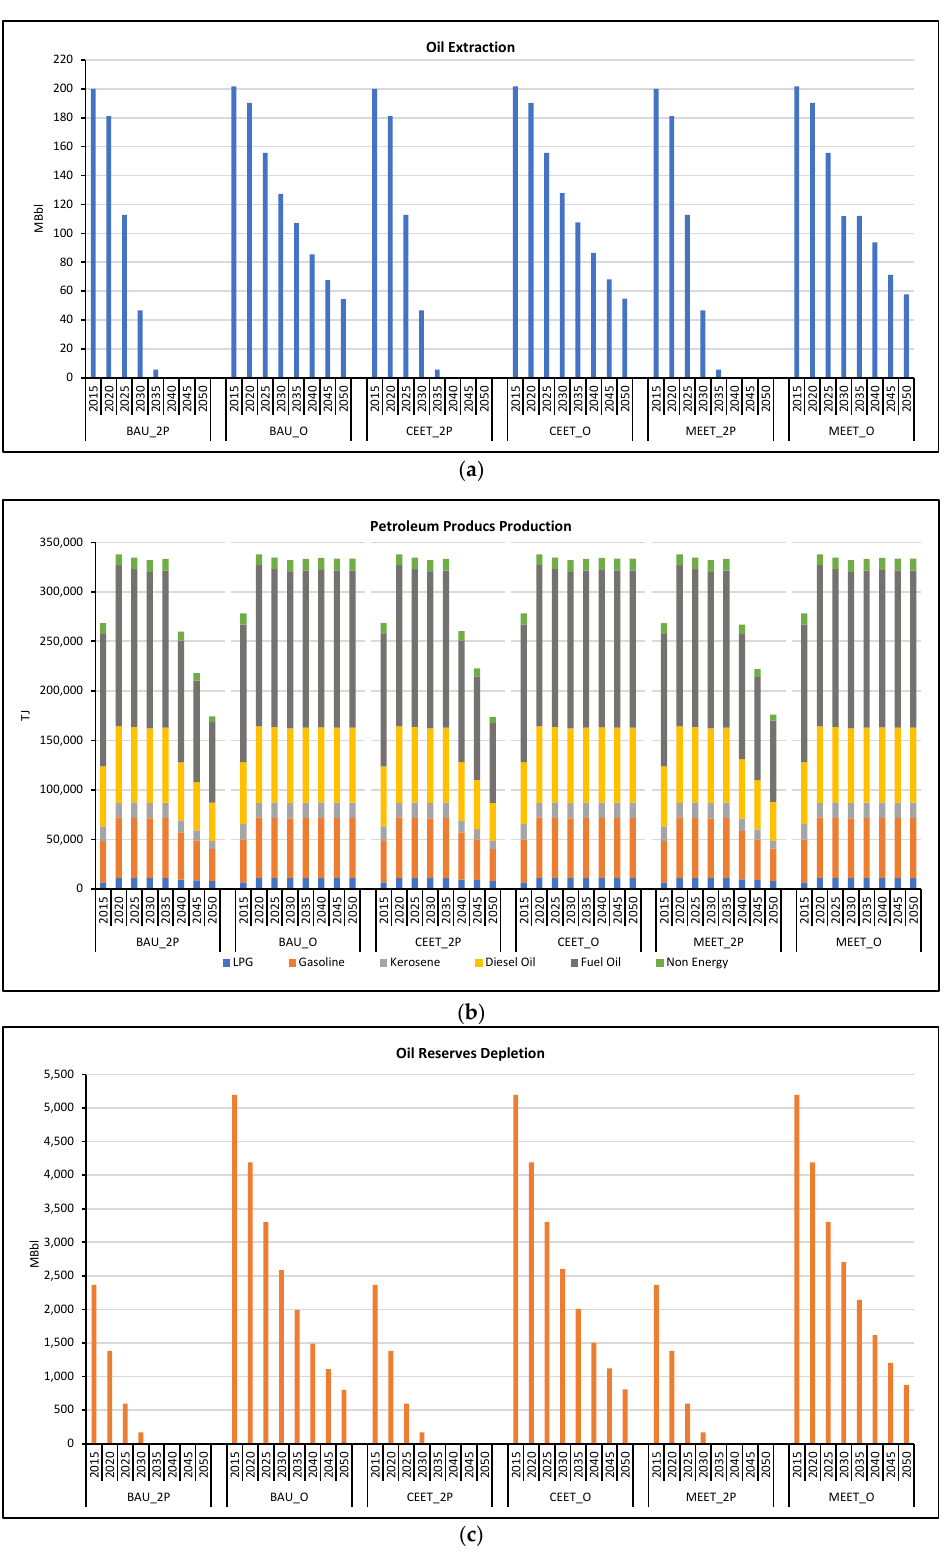
Figure 2. Evolution of ( a ) Oil extraction, ( b ) Petroleum Products production, and ( c ) Oil reserves depletion per scenario.